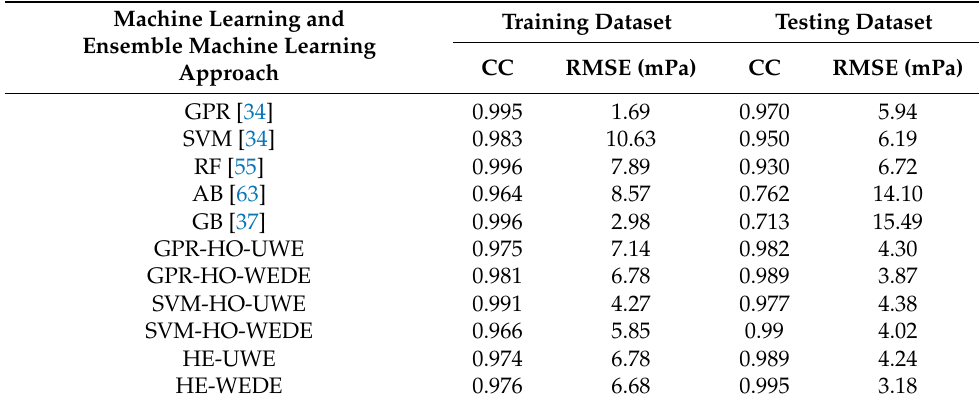
Table 8. Performance of different machine learning models on the FSW-2PI-V1 dataset.